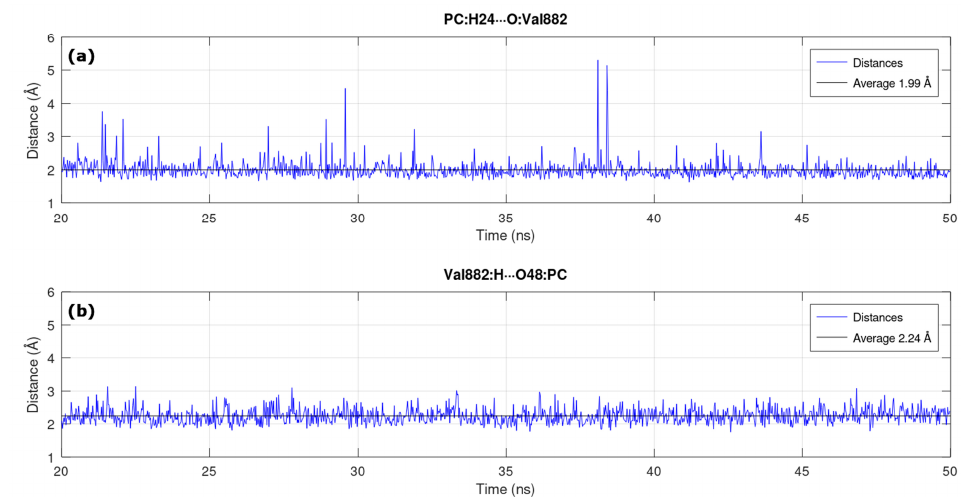
Figure 6. Bond lengths versus time of the two H-bonds with the highest frequency of occurrence in the MD simulation. ( a ) PC:H24 ··· O:Val882; and ( b ) Val882:H ··· O48:PC.